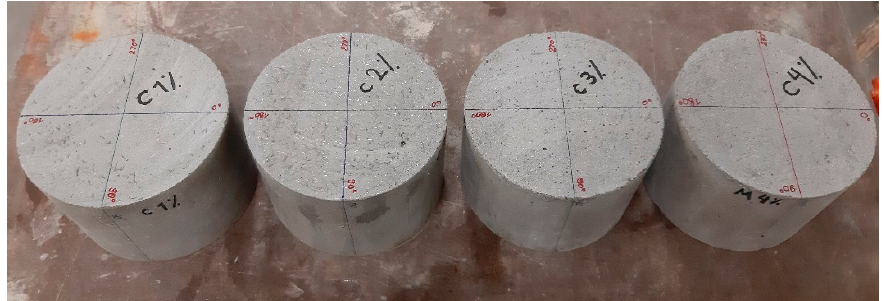
Figure 4. Specimens used in test series A (with original thickness).